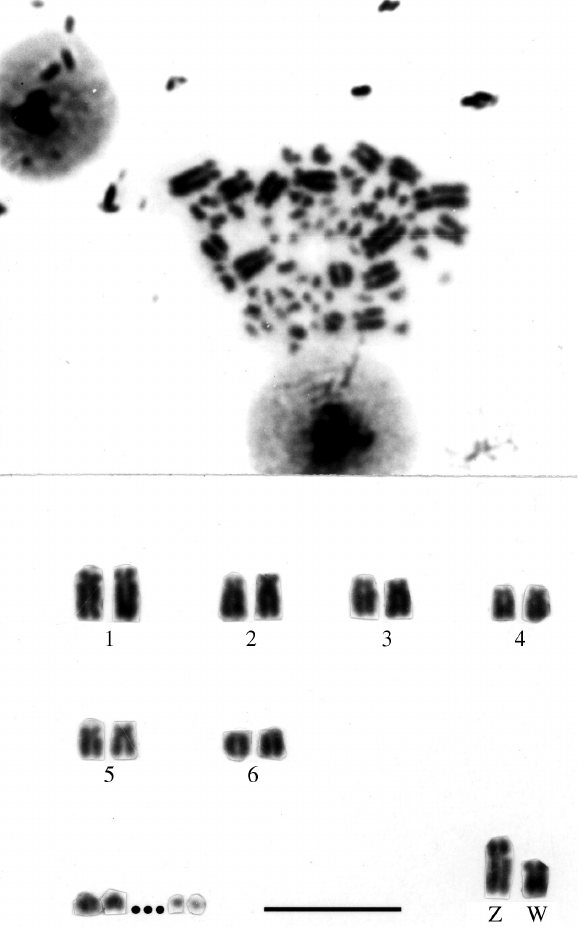
Figure 1 - Conventionally stained mitotic metaphase and female karyotype showing the macrochromosomes and the first and last pairs of microchromosomes of Pionus maximiliani . Bar = 10 µ m.